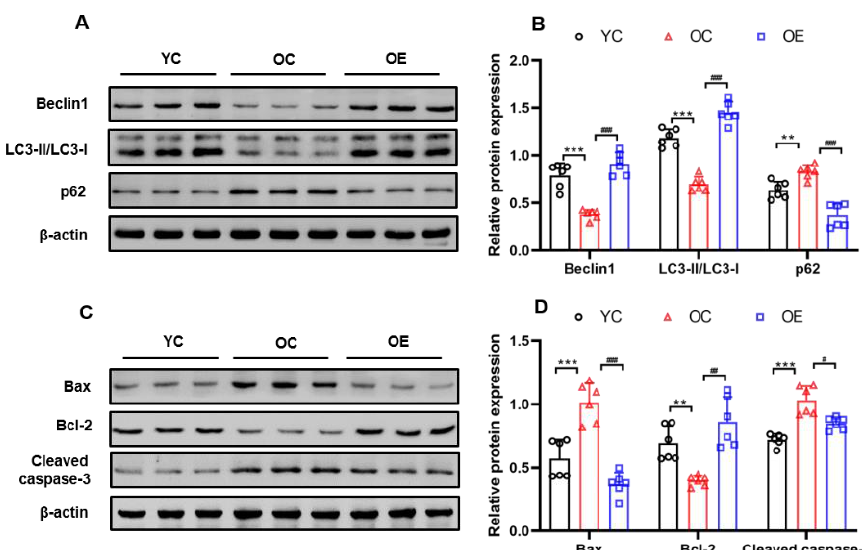
Figure 5. Lifelong aerobic exercise up-regulated the expression of autophagy-related protein Beclin1 and LC3-II/LC3-I ratio and down-regulated the expression of p62 ( A , B ); as well as down-regulated the expression of apoptosis-related proteins such as Bax and cleaved caspase-3 and up-regulated the expression of Bcl-2 ( C , D ) in gastrocnemius muscle of the aged mice evaluated by Western blot. Equal protein loading was confirmed by β -actin. All data are presented as mean ± standard deviation (M ± SD) ( n = 6 mice per group). Group symbols: YC, black circle; OC, red triangle; OE, blue square. *** p < 0.001, ** p < 0.01 vs. YC group; ### p < 0.001, ## p < 0.01 and # p < 0.05 vs. OC group.